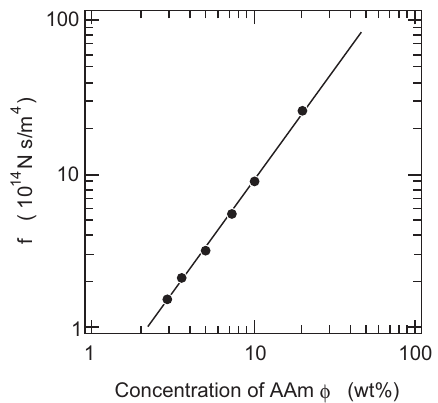
Figure 6. The concentration dependence of the friction coefficient of PAAm gel. The raw value of the friction coefficient is plotted as a function of the concentration of PAAm gel in a double logarithmic manner. The temperature is fixed at 20.0 ◦ C in these measurements. The straight line with the slope of 1.5 is the results of the least squares